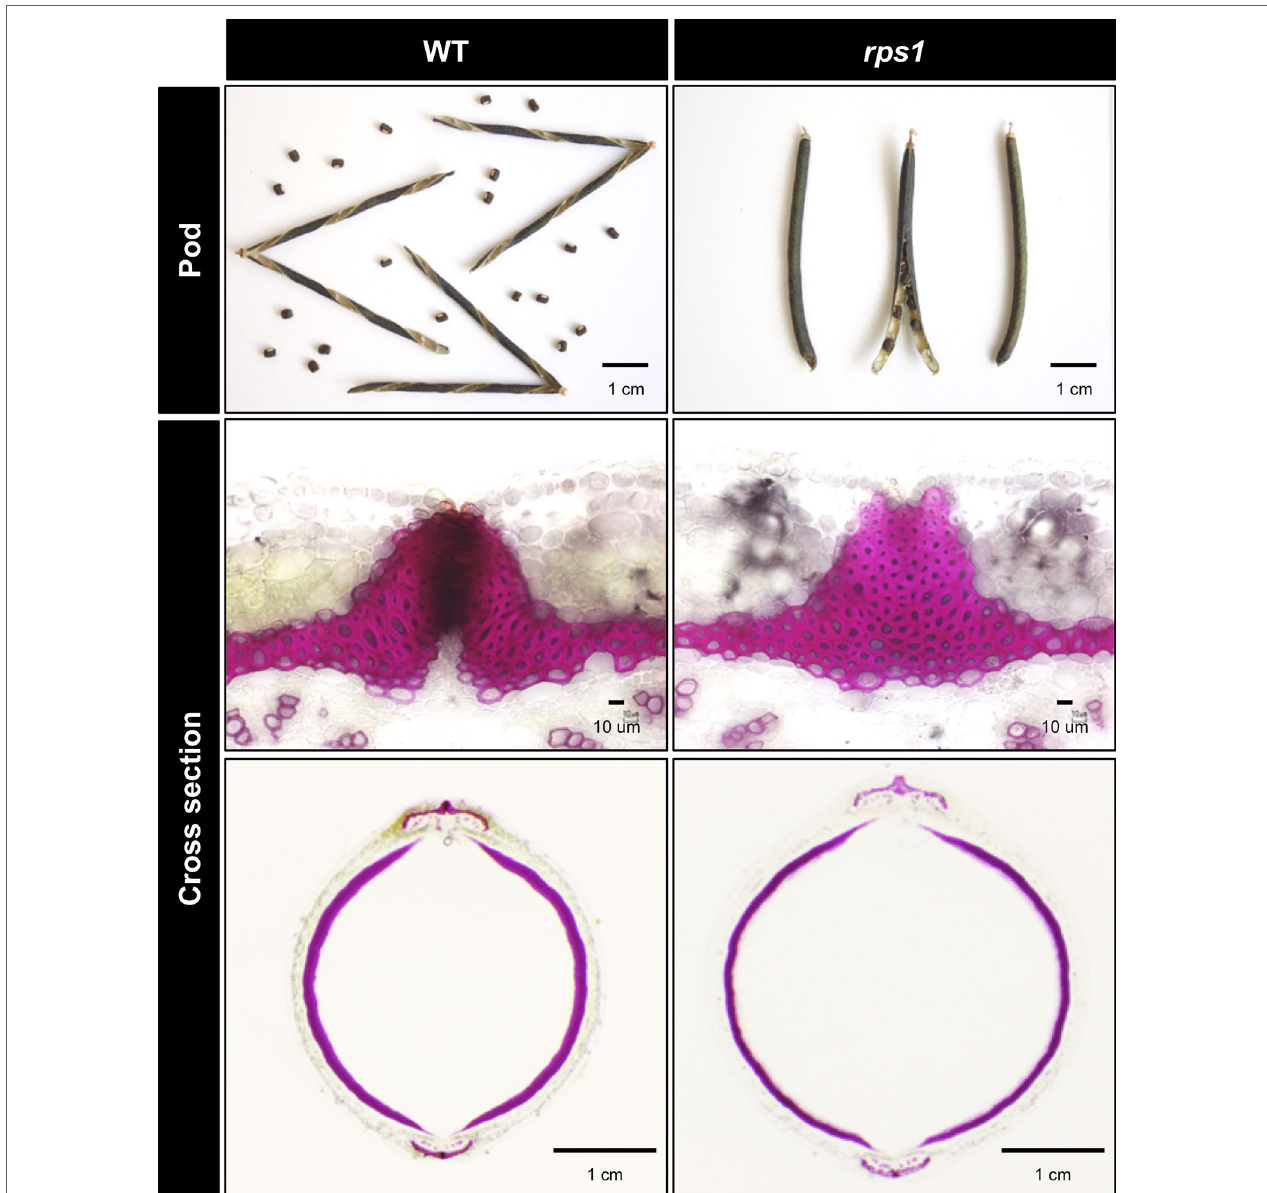
FIgURe 4 | Non-shattering mutant of V. stipulacea . Pod shattering was strongly suppressed in the rps1 mutant, where the abscission layer between the valves were not formed at all, whereas the thickness of sclerenchyma did not greatly change.